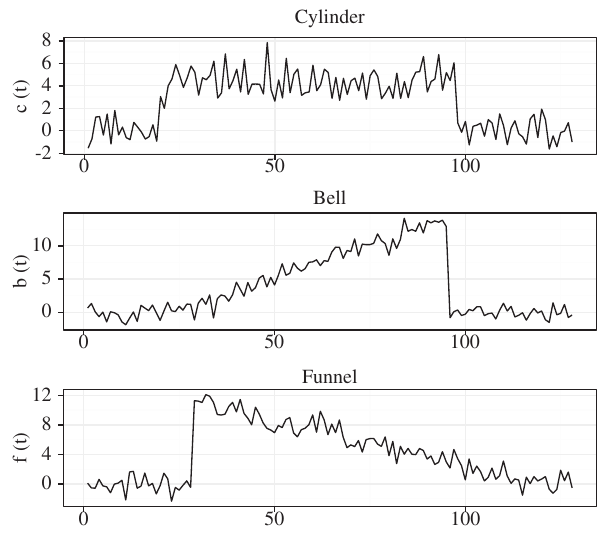
Figure 3. Examples of Cylinder–Bell–Funnel